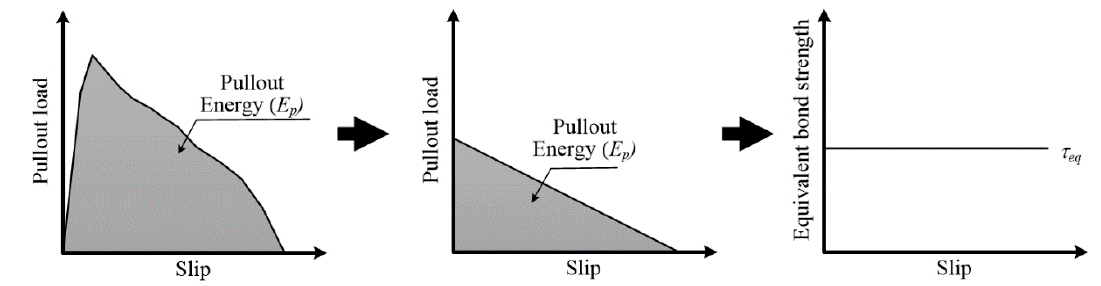
Figure 7. Assumptions underlying the equivalent bond strength calculation [30].